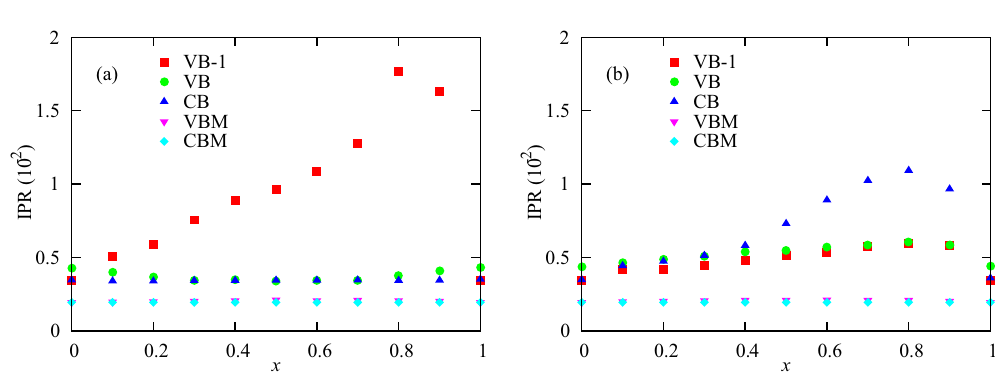
Figure 4. The IPR as a function of the on-site disorder strength ∆  . In Panel (a) we plot the mean value of the IPR for the three energy bands: VB − 1 (red squares), VB (green circles) and CB (blue triangles). The IPR for all three bands increases gradually as  ∆ approaches and exceeds 1 eV. We note here that although we are plotting the mean values over five instances, instance-to-instance fluctuations were small and almost indiscernible in the majority of cases. In Panel (b) we plot, for five instances, the IPR for the states at the VBM (red symbols) and CBM (green symbols). When we calculate the IPR for the VBM and CBM, we take the averages over the states that lie within 0.1 eV from the band edges. The solid and dashed lines are the respective mean values for the five instances. We can see that both lines increase and decrease again as  ∆ increases. The counter-intuitive decrease occurs in the regime where there is no boundary between the VB and CB, and this delocalization tendency should therefore not be taken as reflecting the transport properties at the VBM and CBM. In ( b ) we see that the tendency towards localization is more sudden than when taking the mean values for entire energy bands. The localization of the states at the VBM and CBM occurs around ~ ∆ . − 0 2 1  eV, with the VBM states becoming localized for somewhat smaller values of ∆  .